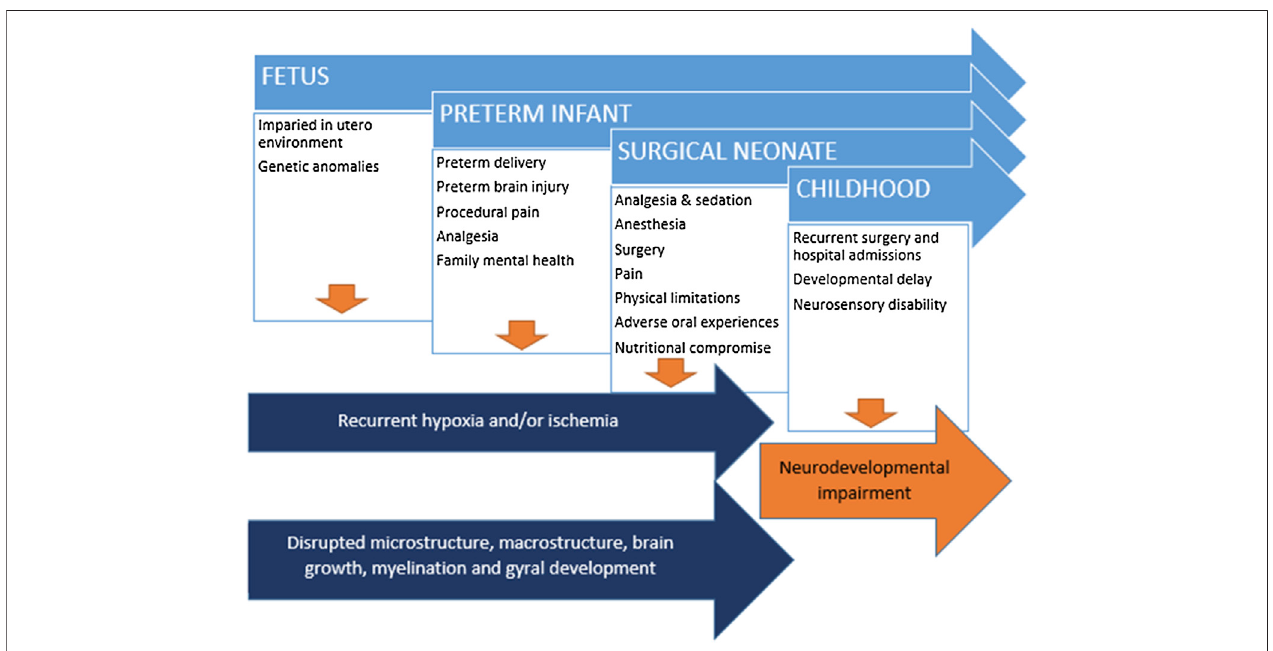
FIGURE 1 | Disrupted brain development and brain injury in context of cumulative insults and risk factors subsequent developmental delay and neurodevelopmental impairment.